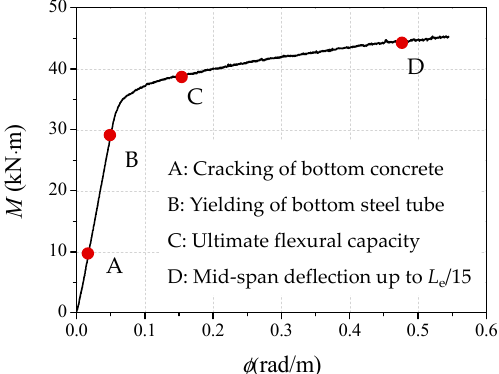
Figure 6. Typical moment ( M )-versus-curvature ( ϕ m ) curve.